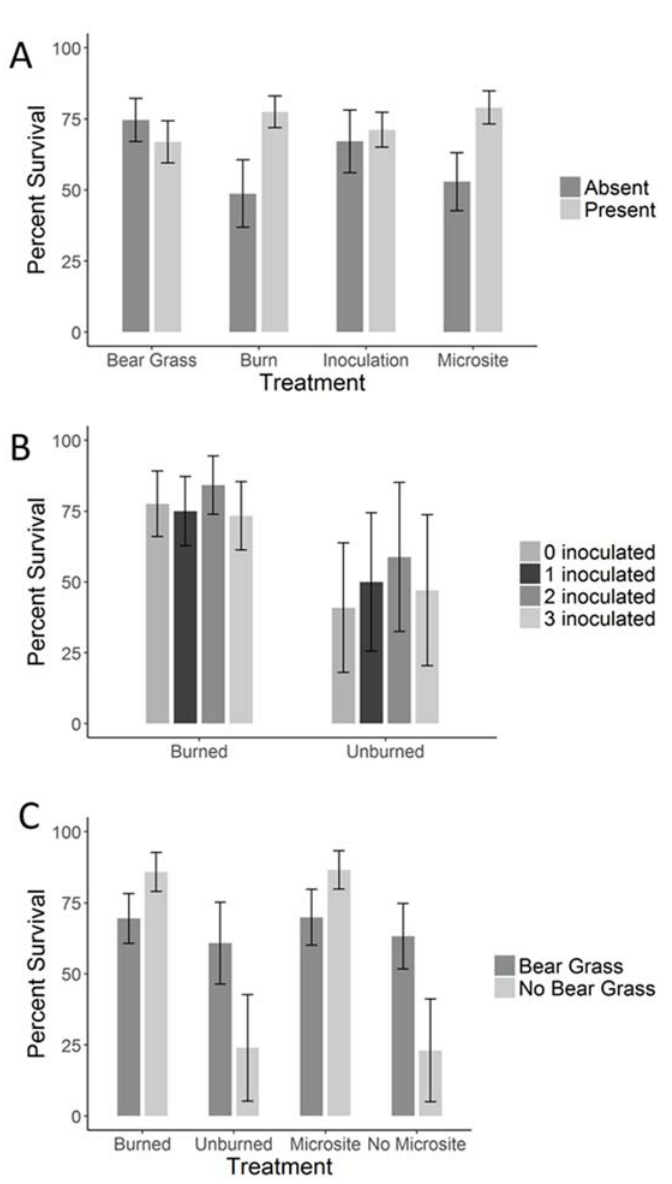
Figure 5. Survival of whitebark pine seedling clusters after seven years summarized for ( A ). individual variables: with and without beargrass X 2 (1, n = 307) = 2.20, p = 0.14, with and without burning X 2 (1, n = 307) = 22.75, p < 0.001, with and without inoculation X 2 (1, n = 307) = 2.2, p = 0.14, with and without inoculation X 2 (1, n = 307) = 0.49, p = 0.49, with and without a microsite X 2 (1, n = 307) = 22.22, p < 0.0015. ( B ). with and without ectomycorrhizal inoculation of 1, 2, or 3 seedlings in each cluster on burned and unburned sites. For burned sites X 2 (3, n = 231) = 2.27, p = 0.52, for unburned sites X 2 (3, n = 76) = 1.26, p = 0.74. ( C ). burned with and without beargrass X 2 (1, n = 231) = 8.85, p = 0.003, unburned with and without beargrass X 2 (1, n = 76) = 9.09, p = 0.003, microsite present with and without beargrass X 2 (1, n = 205) = 8.56, p = 0.003, microsite absent and without beargrass X 2 (1, n = 102) = 12.49, p ˂ 0.001.